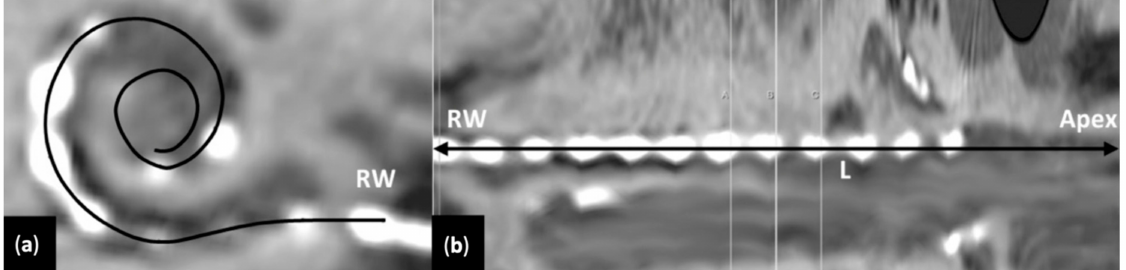
Figure 3. Postoperative CT scans analysis and reconstruction: ( a ) Oblique view of the cochlea on a multiplanar reconstruction (MPR) with minimal intensity projection showed the full length of the electrode array; ( b ) A reconstruction of the image ( a ) in a curvilinear plane unfolded the cochlear spiral; The relative distance of each electrode to the round window (RW) was measured. Since the electrodes are not on the same plane, they cannot be all visualized on the